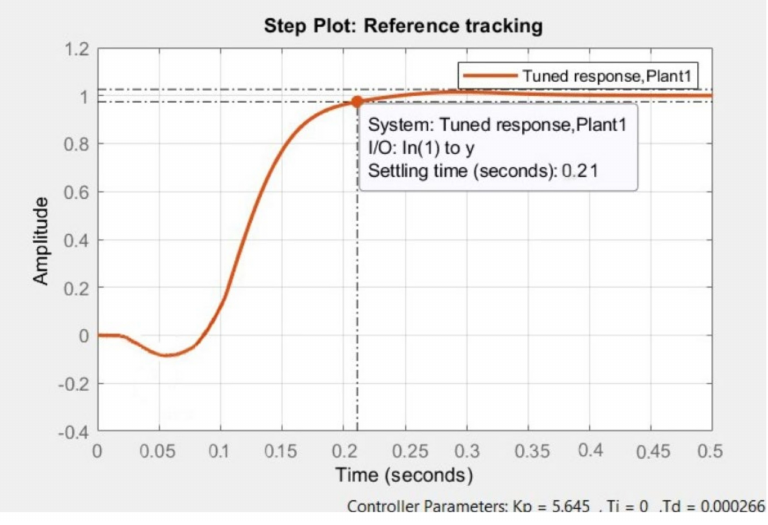
Figure 11. Control Conditions